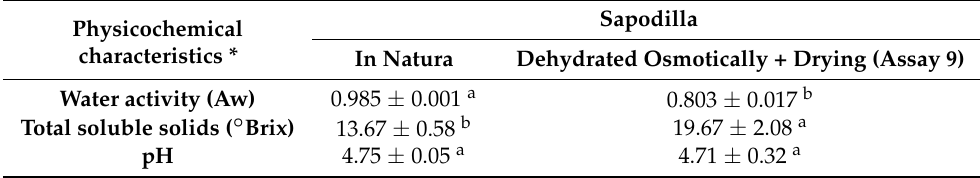
Table 8. Physicochemical characteristics of in natura and osmotically dehydrated